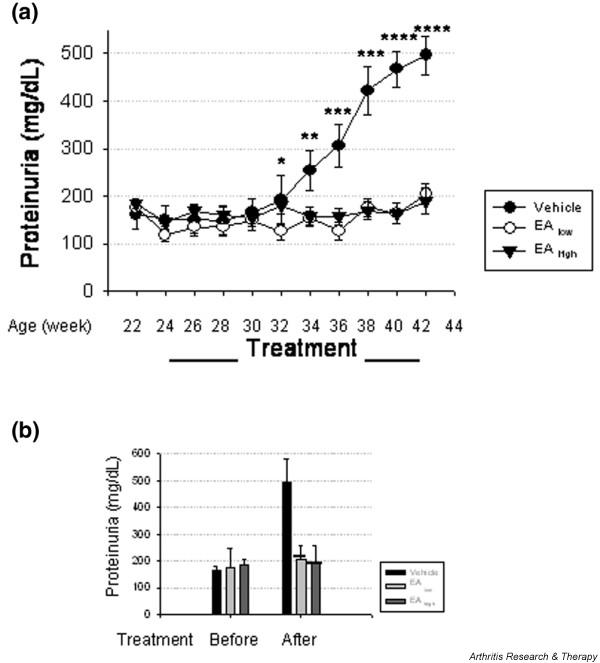
Impact of treatment with Tripterygium wilfordii Hook F on proteinuria in NZB/W F1 mice. Proteinuria was determined by spectrophotometry as described in Materials and methods. Data are the means ± standard error of the mean of each group. Numbers in parentheses indicate the animals examined. (a) Changes in proteinuria in NZB/WF1 mice during the treatment course. Statistical analysis was done for proteinuria measured before and at each time point after treatment for each group. Proteinuria increased significantly in the mice of the vehicle group (*p < 0.05; ***p < 0.001; ****p < 0.0001; before treatment verses after treatment). (b) Proteinuria was compared between groups before and after treatment. No significant difference was determined before treatment between the three groups. After treatment, proteinuria was significantly higher in the vehicle treated mice than in mice treated with the ethyl acetate (EA) extract (**p < 0.0026, EAlow versus vehicle; ****p < 0.0001, EAhigh versus vehicle).